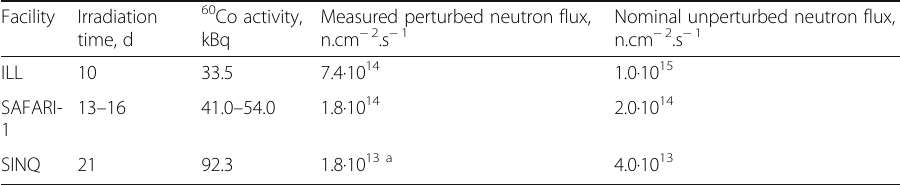
Table 1 Measured neutron fluxes of the irradiation facilities used for 161 Tb production Facility Irradiation time,